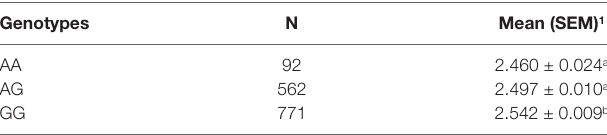
TABLE 3 | IMF (%) of different genotypes for SNP